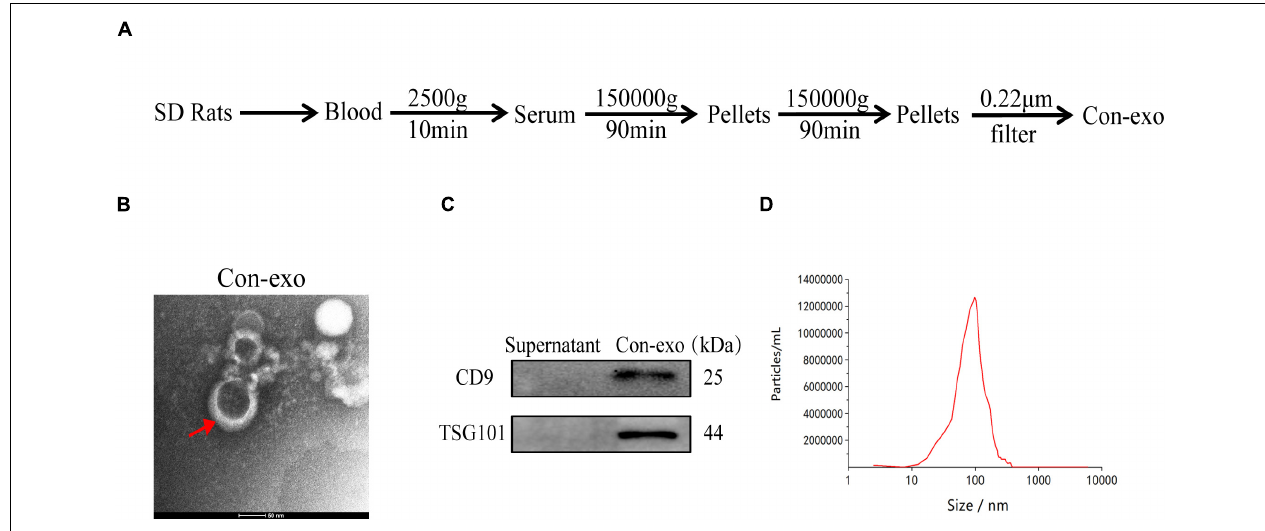
FIGURE 1 | Isolation and characterization of serum exosomes. (A) Schematic representation of serum exosomes (Con-exo) isolated from rats. (B) Con-exo was photographed by transmission electron microscopy (TEM). Scale bar = 50 nm. (C) Representative immunoblotting images of exosomal markers such as CD9 and TSG101 in Con-exo. (D) Particle size of Con-exo was measured by nanoparticle tracing analysis.